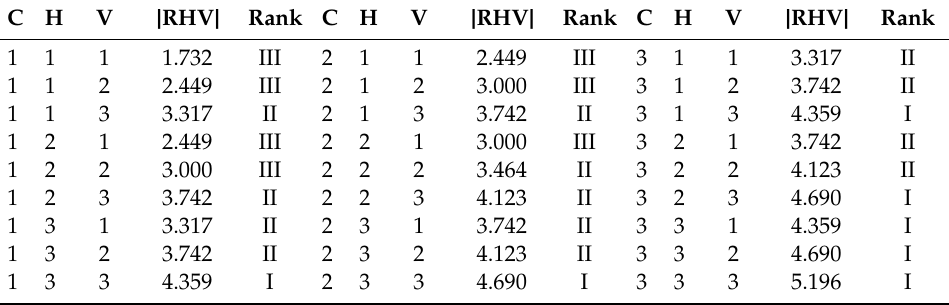
Table 4. Classification criteria of rockfall hazard assessment in study